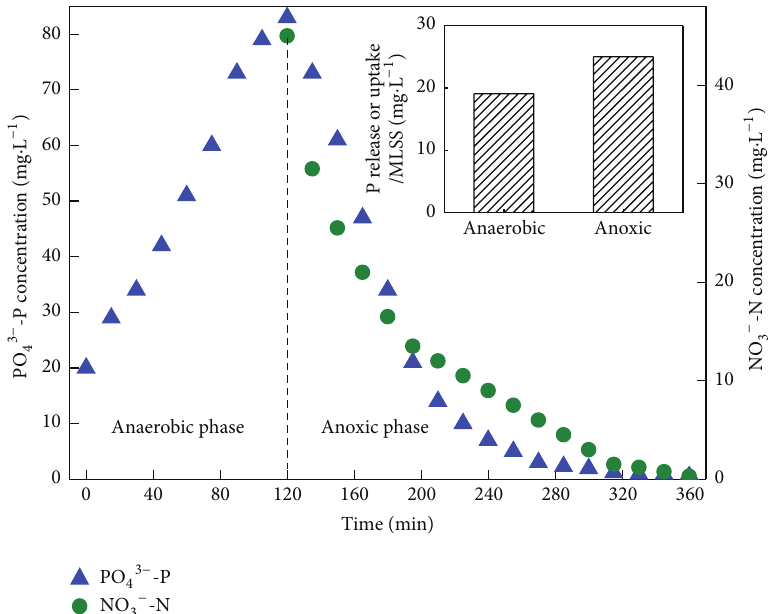
Figure 2: Variation of PO 43− -P and NO 3− -N concentrations in anaerobic and anoxic phase and P release and uptake per MLSS throughout the whole batch test.